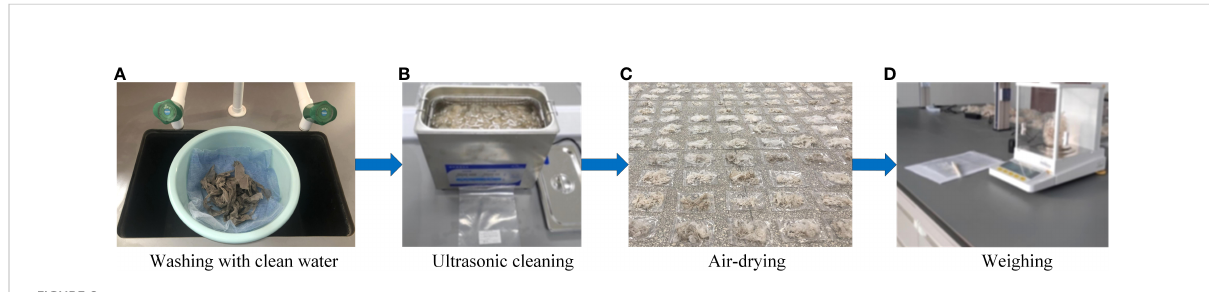
FIGURE 8 Calculation process of the residual fi lm weight. (A) Washing with clean water; (B) Ultrasonic cleaning; (C) Air-drying; (D)